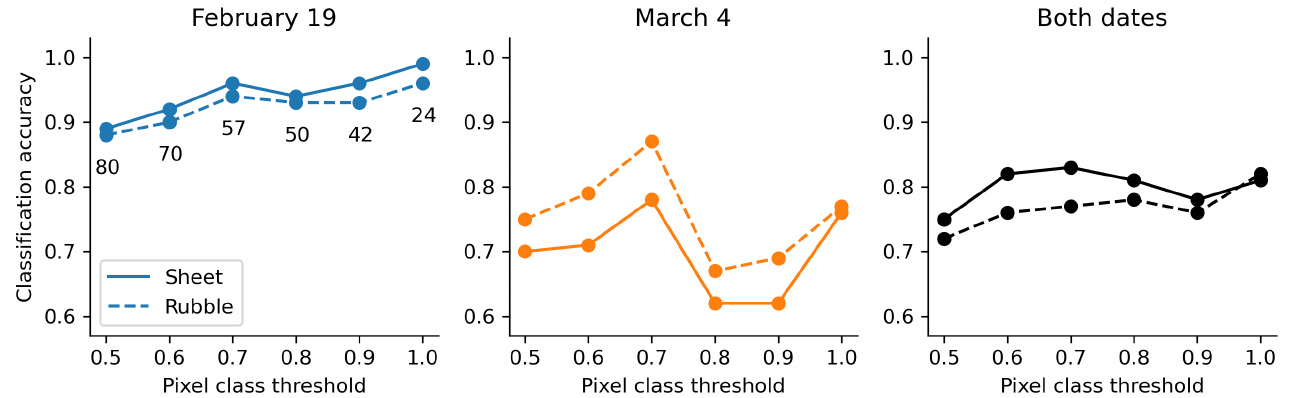
Figure 7. RF classification accuracy for sheet ice (solid lines) and rubble ice (dashed lines) using models trained with data from 19 February only ( left panel ), 4 March only ( middle panel ), and both dates combined ( right panel ). The numerical labels in the 19 February panel denote the number of samples selected from each class on each date in the overall